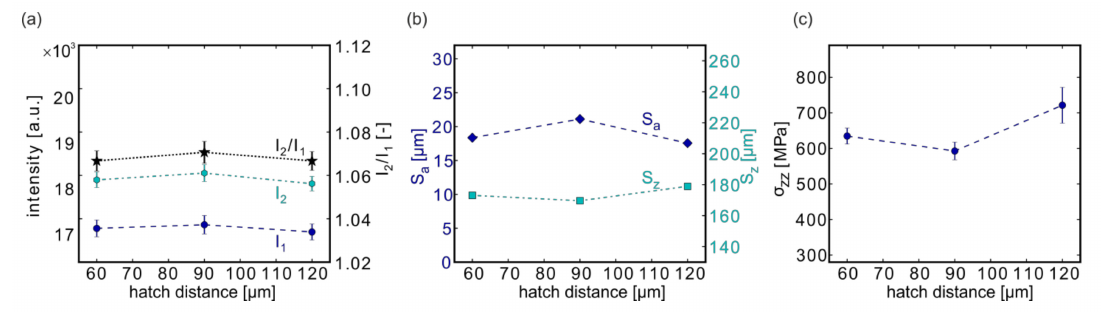
Figure 10. Influence of the hatch distance on the MPM data ( a ), on the surface roughness ( b ), and on the RS ( c ). Depicted are the results from samples #15 (60 µ m), #05 (90 µ m), and #16 (120 µ m). Note: The lines connecting the measurement points are only provided as a guide for the eye.